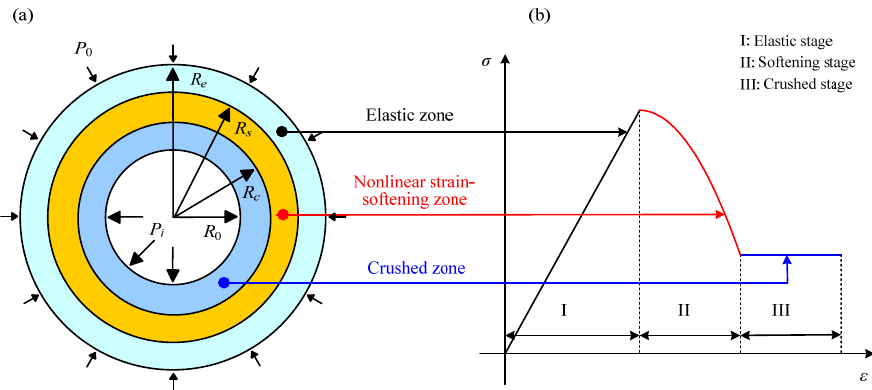
Figure 2. Mechanical models. ( a ) Three-region model of a tunnel cylindrical considering seepage force. ( b ) Nonlinear strain-softening model of surrounding rock.